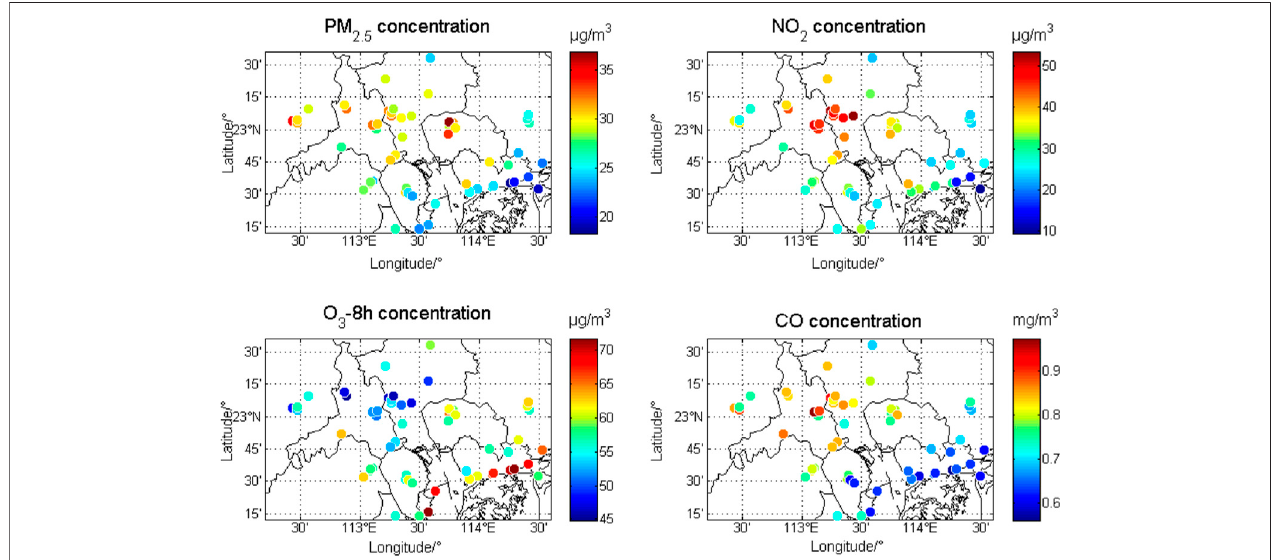
FIGURE 2 | Mean concentrations of PM 2.5 , NO 2 , O 3 – 8h , and CO at various stations.